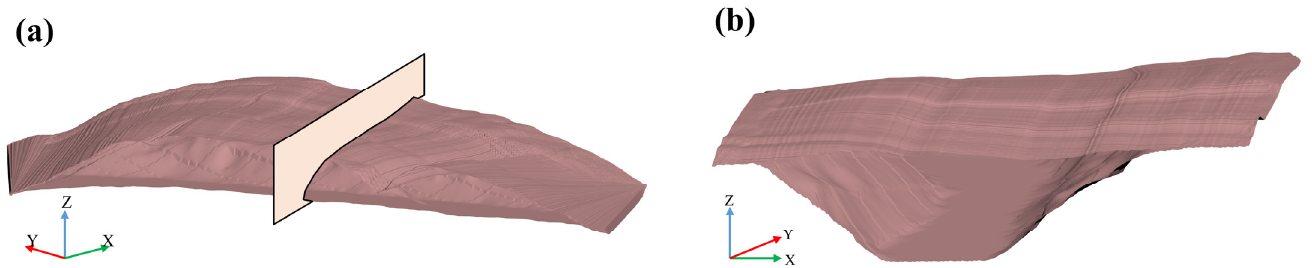
Figure 22. The 3D solid model of C4. ( a ) The front view, and ( b ) the cut view. The light yellow polygon is the cutting plane.